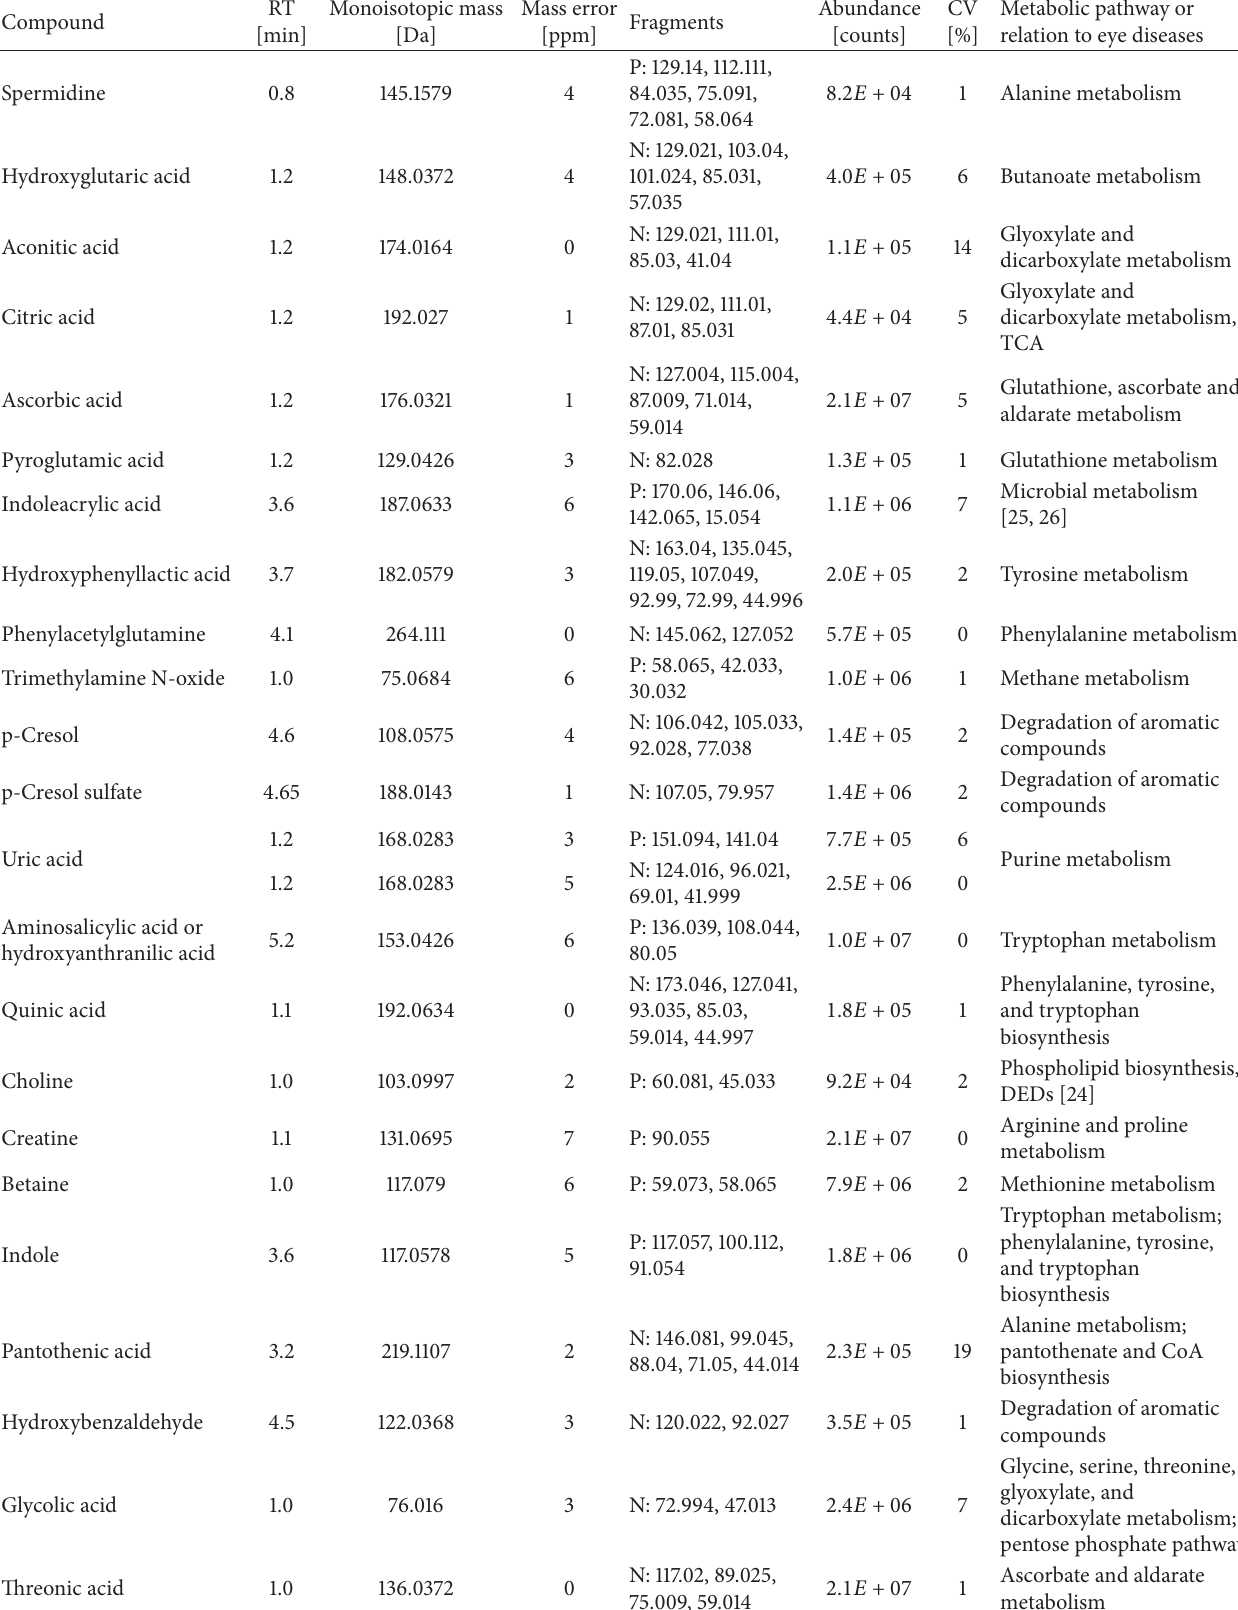
Table 6: The list of other metabolites detected in aqueous